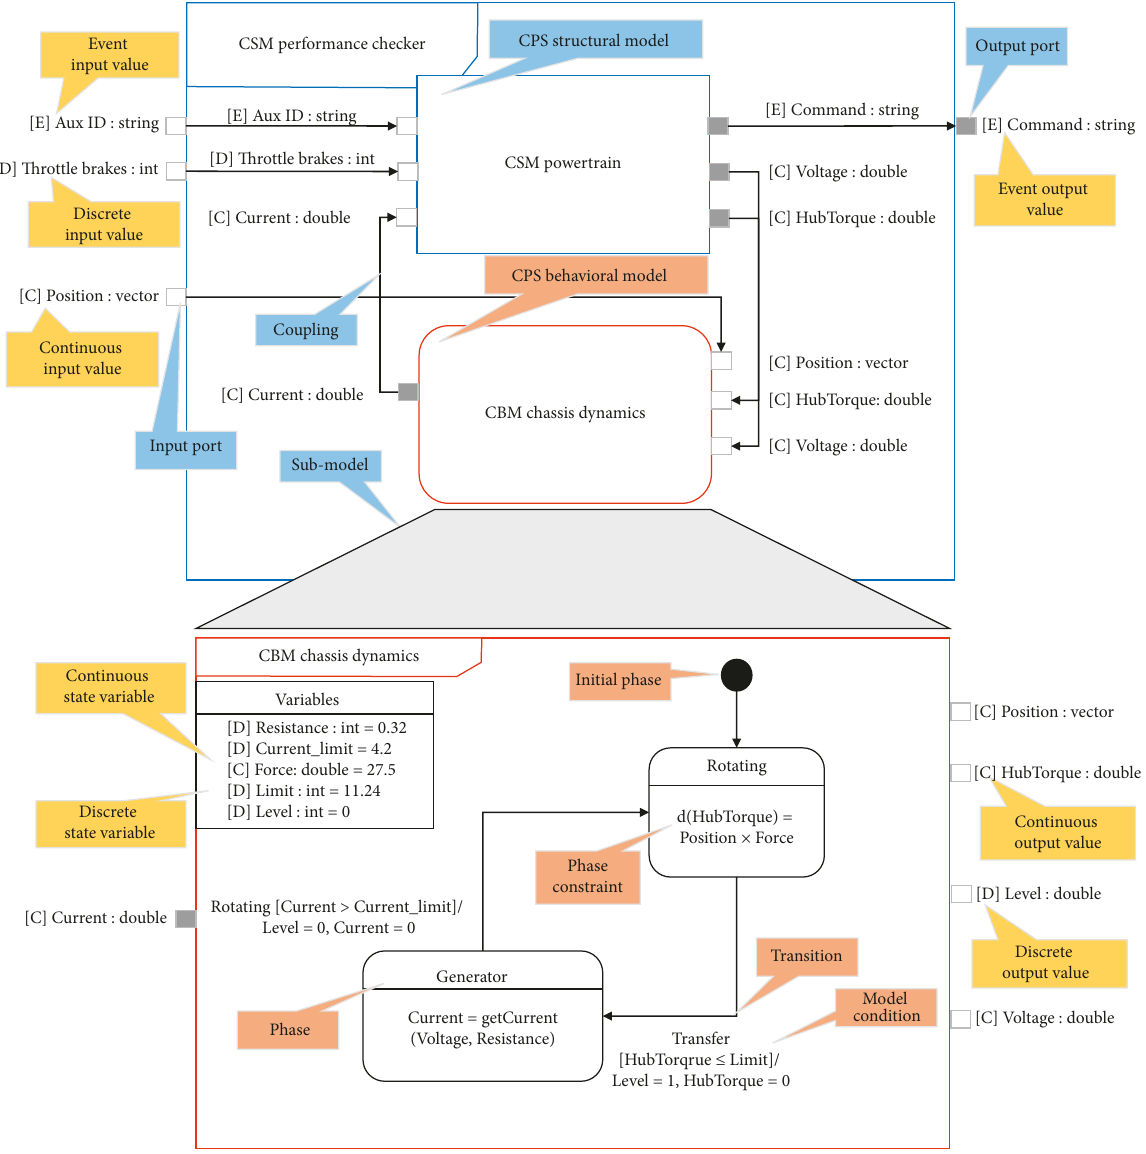
Figure 4: CPPS models based on